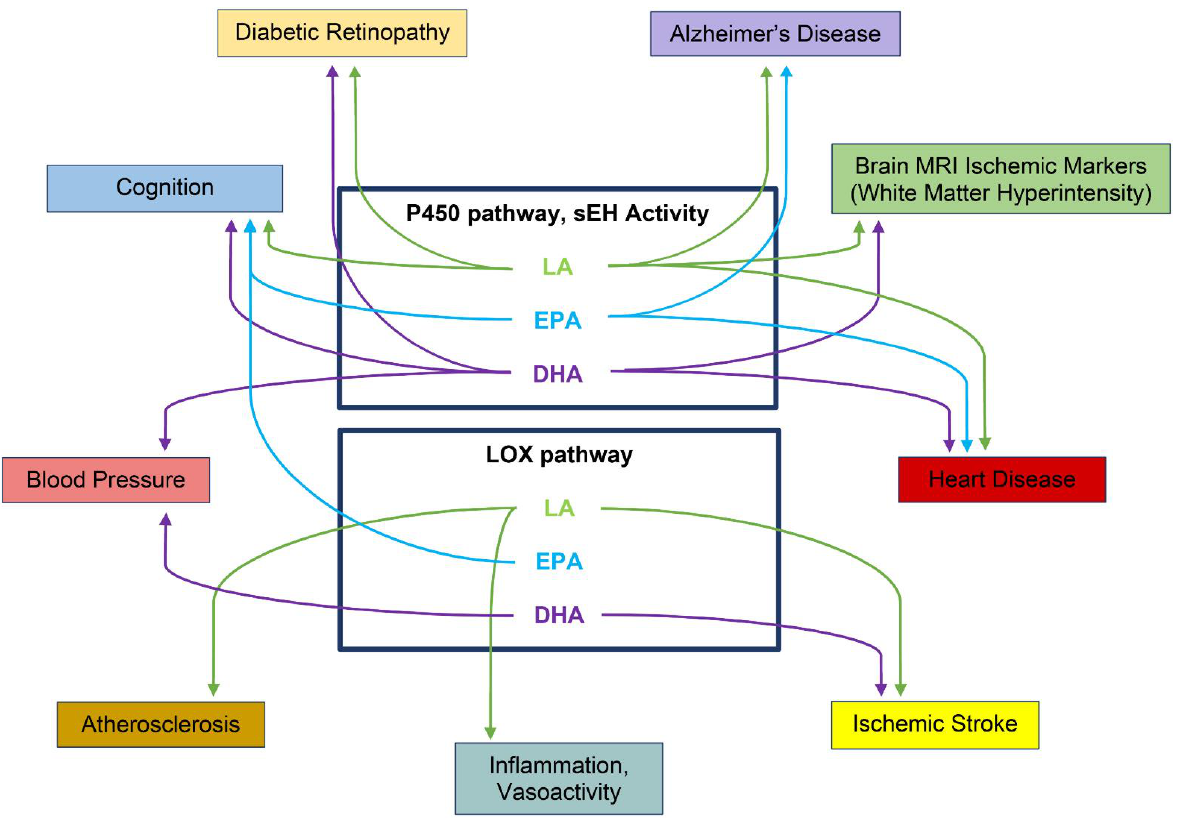
Figure 4. Schematic diagram of oxylipins and associated clinical outcomes. Highlights of the major oxidation pathways for linoleic acid (LA), eicosapentaenoic acid (EPA), and docosahexaenoic acid (DHA) that include cytochrome P450 (P450 pathway)-soluble epoxide hydrolase (sEH), and